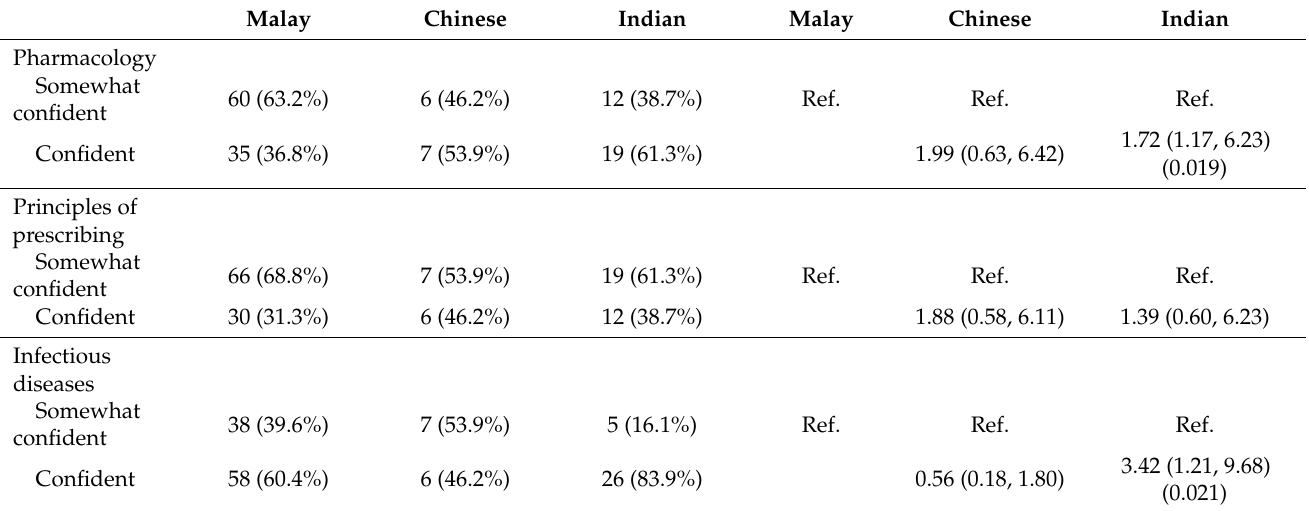
Table 9. Frequency and odds of race/ethnicity in the comparative confidence in knowledge.